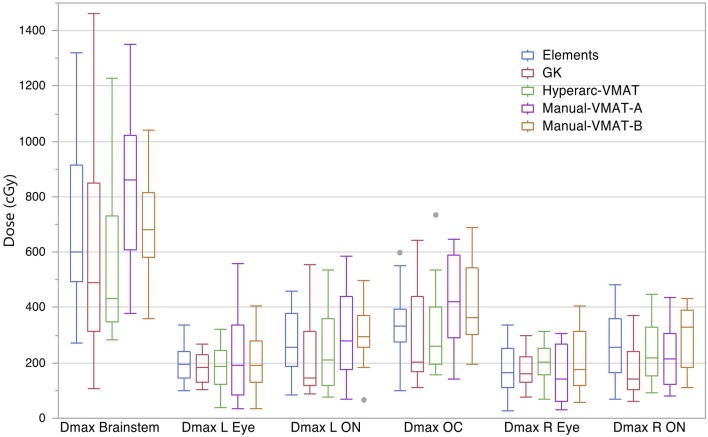
Box plot results per SRS plan type for the following dosimetric parameters across all patients: the maximum dose to the brainstem (Dmax Brainstem), maximum dose to the left eye and optic nerve (Dmax L Eye and Dmax L ON), maximum dose to the right eye and optic nerve (Dmax R Eye and Dmax R ON), and maximum dose to the optic chiasm (Dmax OC).